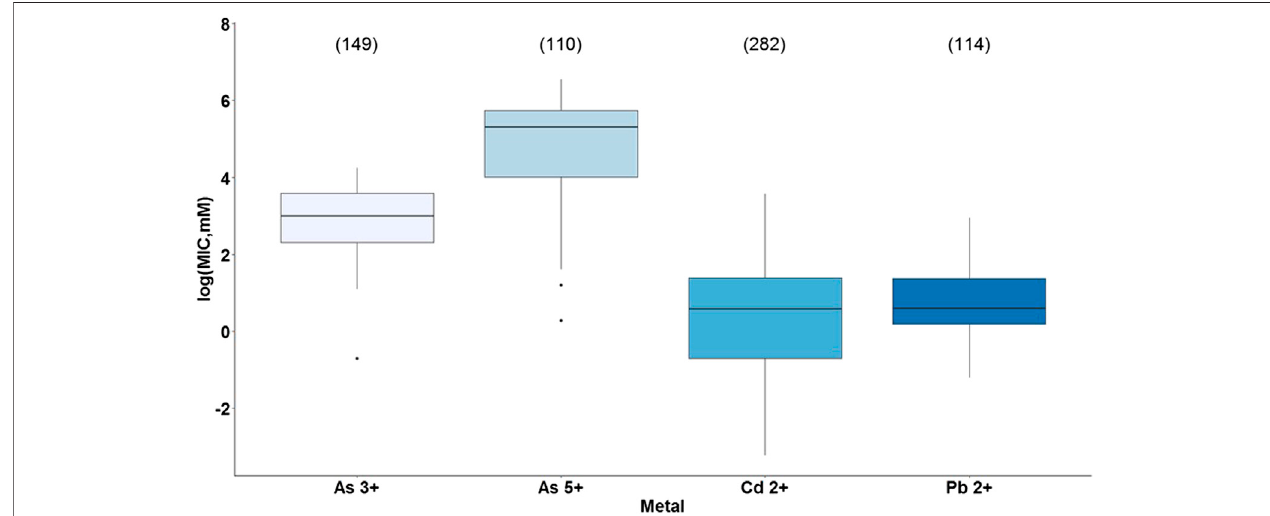
FIGURE 4 | Bacterial metal tolerance in terms of the logarithm of the Minimum Inhibitory Concentration (MIC), as a function of the type of metal (As 3+ . As 5+ . Cd 2+ , Pb 2+ ) analyzed with ANOVA in RStudio 3.5.1. We present an analysis of 655 MIC values obtained from different research articles of different strains/species of bacteria associated with the plant microbiome. The number of reports for each metal is indicated in parentheses.